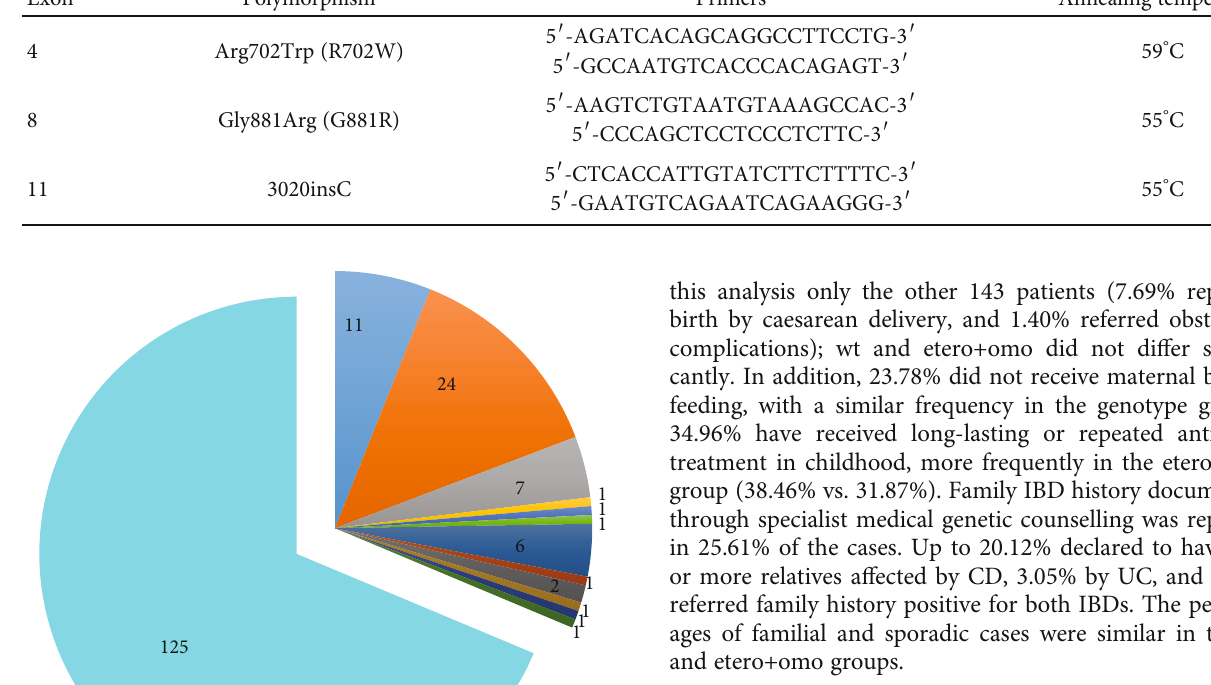
Table 2: Primers and PCR condition used for the detection of R702W, G881R, and 3020insC polymorphisms in NOD2 gene. Exon